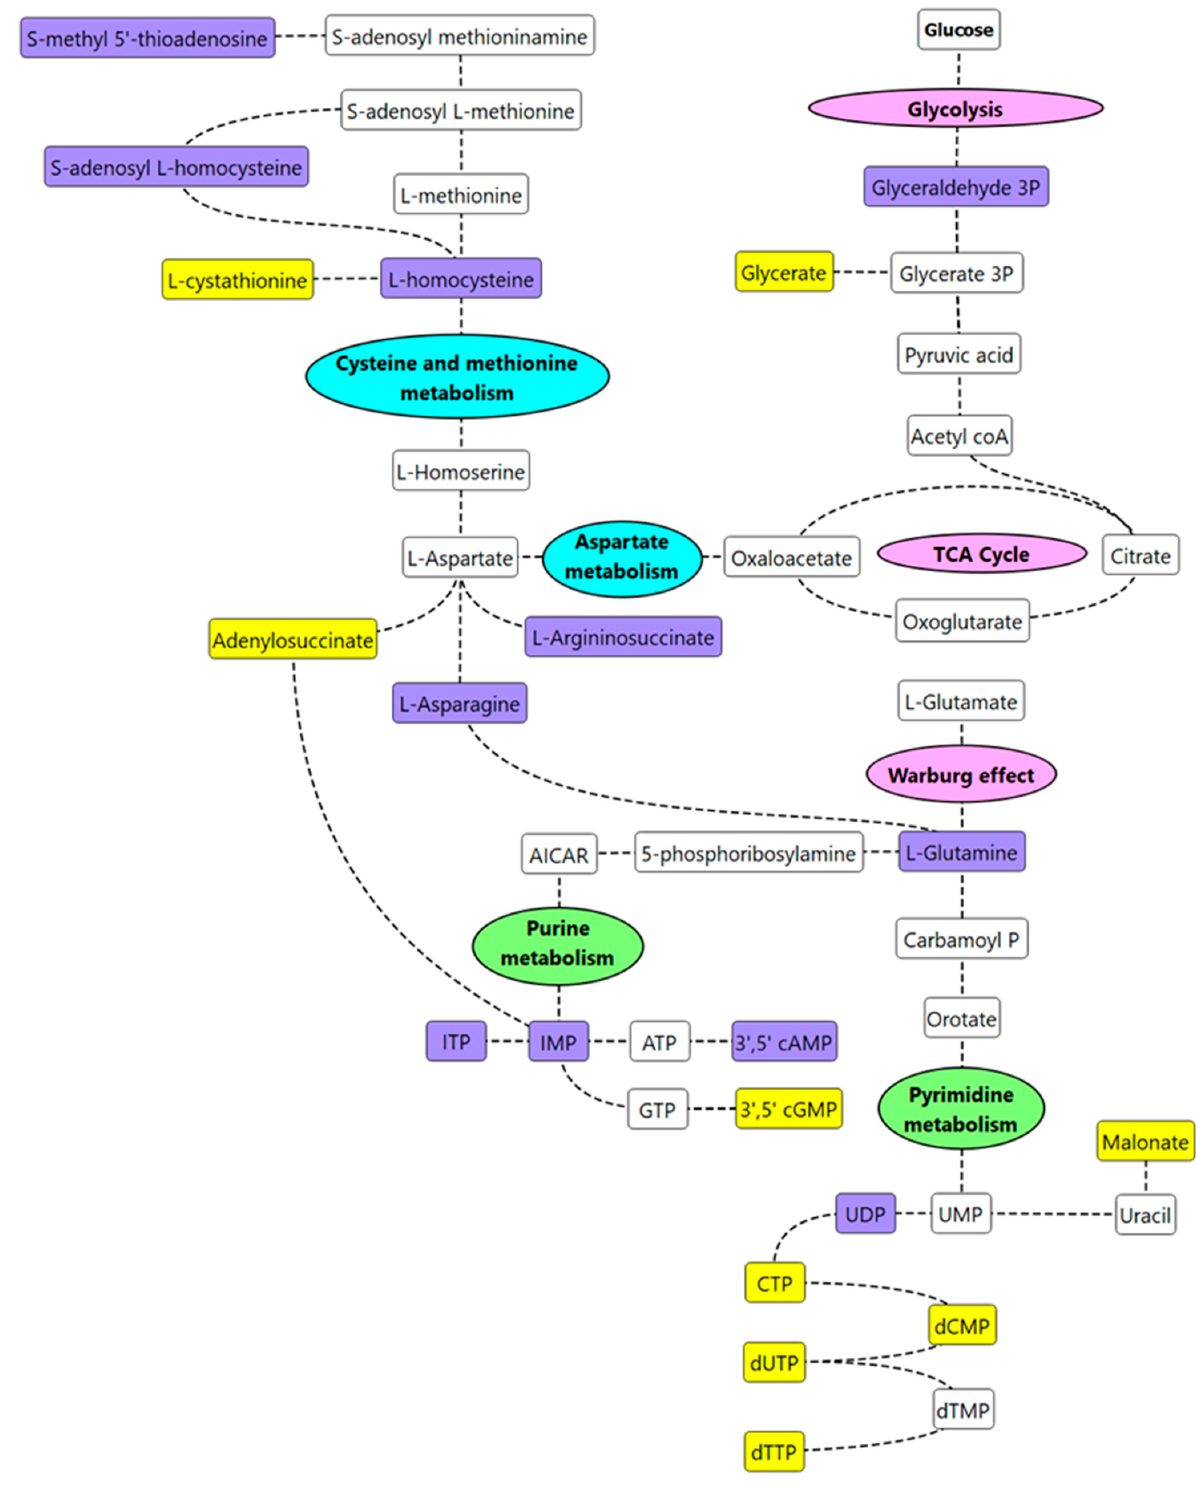
Figure 6. Curated metabolic pathway of key metabolism changes in IP subjects. Note, purple- colored metabolites are significant metabolites/putative biomarkers that are higher in IP subjects vs. healthy subjects; yellow-colored metabolites are significant metabolites/putative biomarkers that are lower in IP subjects vs. healthy subjects. Key metabolic pathways of interest identified from the pathway enrichment and impact analysis are annotated in pink (energy metabolism), green (nucleotide metabolism), or blue (amino acid